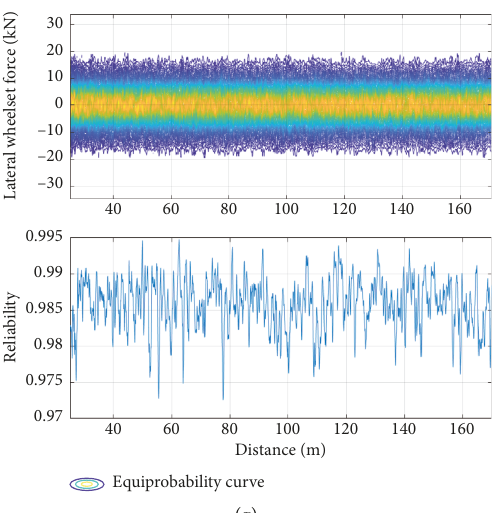
Figure 13: Equal-probability and reliability curves of the train safety evaluation indices. Reduction rates of left wheel load (a) and right wheel load (b). Derailment coefficients of left wheel load (c) and right wheel load (d). Vertical acceleration of car body (e). Lateral ac- celeration of car body (f). Lateral wheelset force (g).